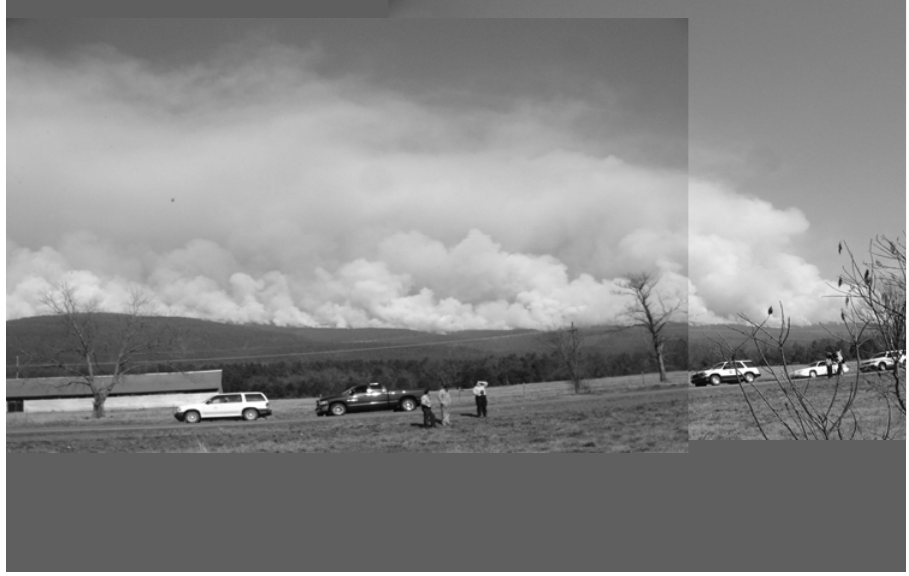
Figure 2. Photo-images of the smoke plume above the 27 February 2004 Magazine Mountain, AR, prescribed